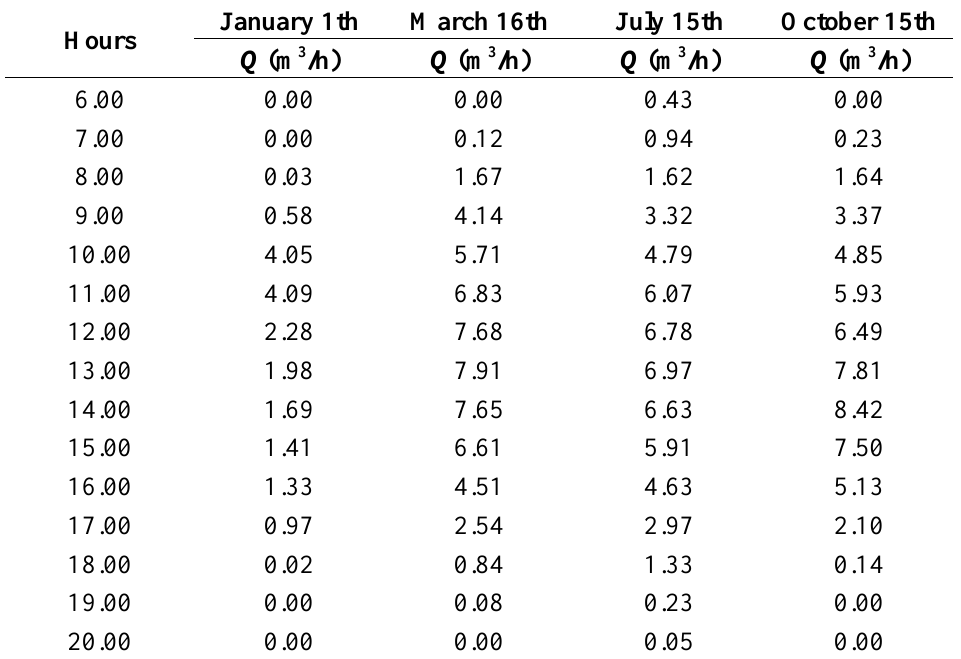
Table 4. Measured water flow rate for the pvwps in January 1th, March 16th, July 15th, October 15th, 2009 (Bel Khchab station).